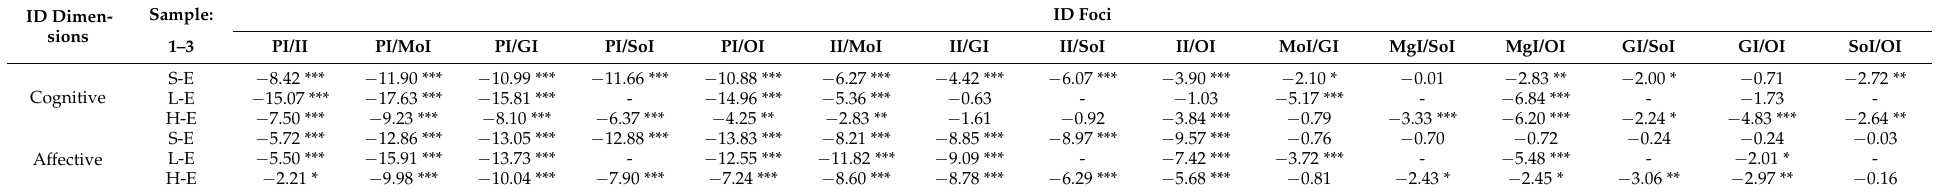
Table 2. Comparison of ID Foci for Each Dimension